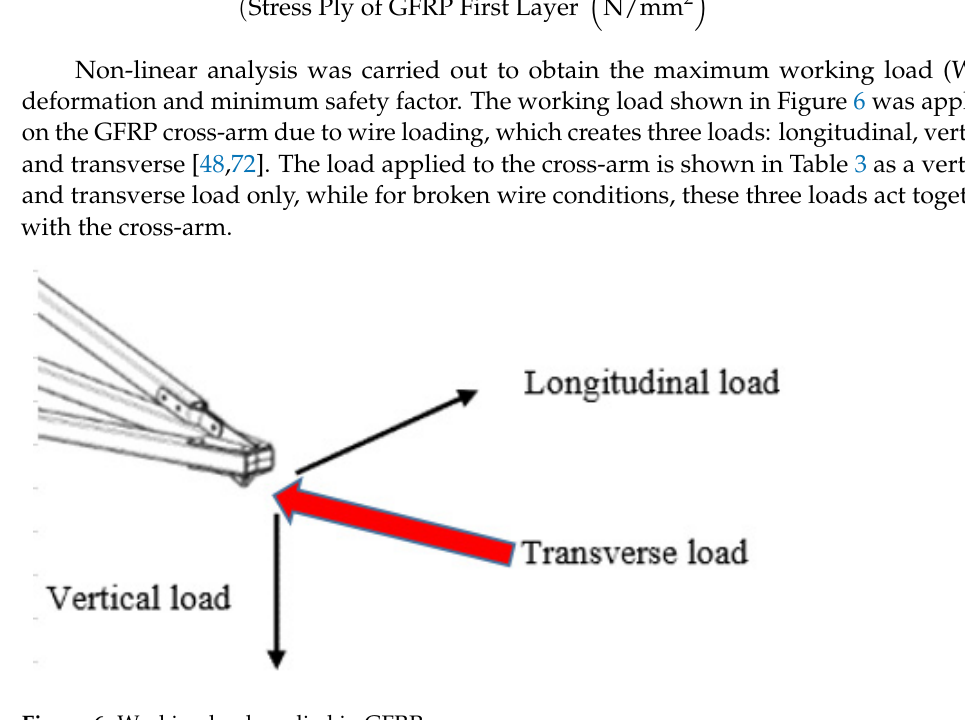
8 of 19 Figure 5. Typical deformed shape of GFRP cross ‐ arm.